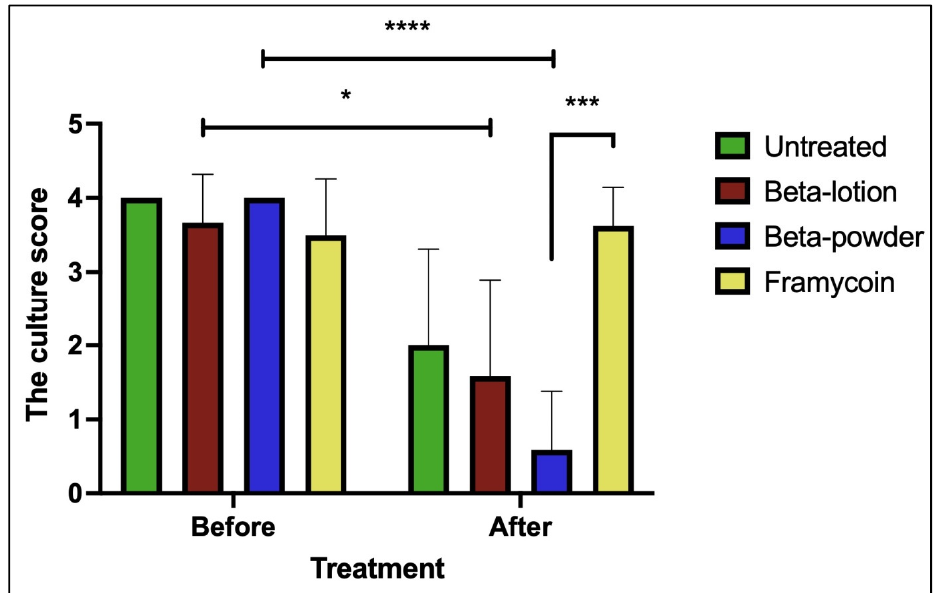
Figure 2. The effects of beta-acids on MRSA growth . Quantitation of MRSA in wounds before and on day 10 (after) of the treatment protocol is shown. Statistical significance (nonparametric Kruskal–Wallis test, multiple comparison test): * p < 0.05, ** p < 0.01, *** p < 0.001, **** p < 0.0001.